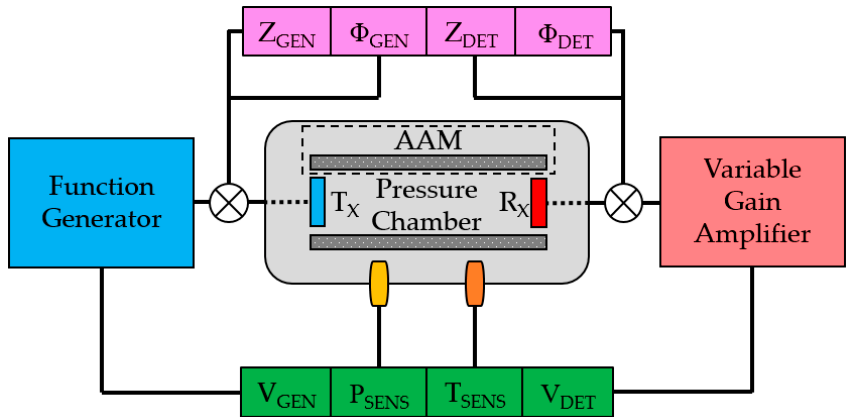
Figure 3. Overview of the experimental process, showing the parameters monitored during each experiment. The electrical characteristics of the transducers were measured in a step distinct from that of the pitch-catch ultrasound performance acquisition, and AAM refers to acoustically-absorbent